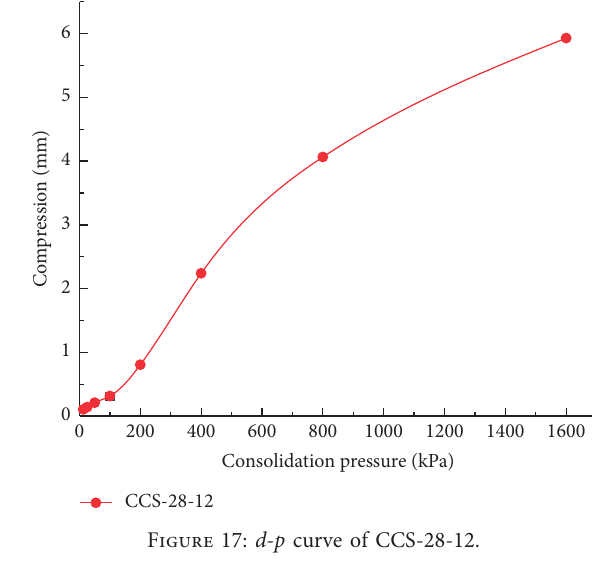
Figure 17: d - p curve of CCS-28-12.